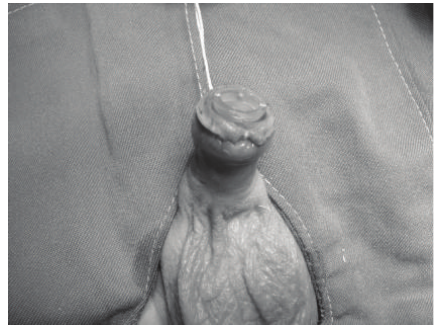
Figure 4: Cutting the